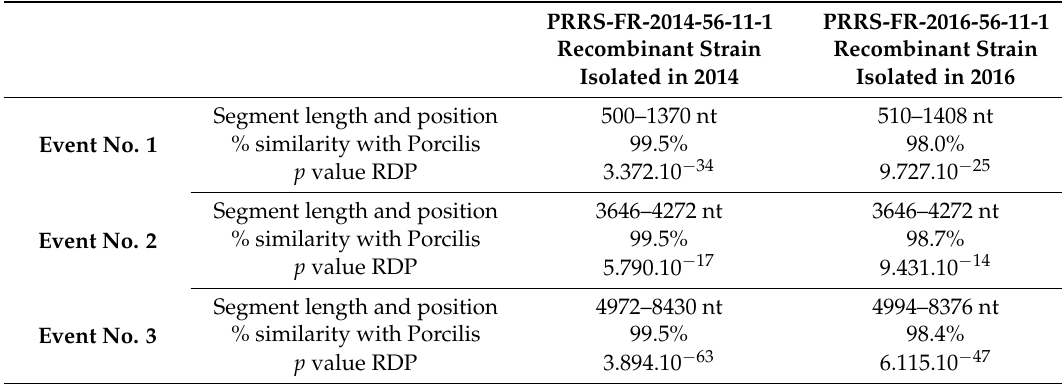
Figure 4. Full-genome similarities between the recombinant strain from 2016 and the vaccine strains or the recombinant strain from 2014. ( a ) Comparison of full-genome similarities with the recombinant strain isolated in 2016 and the Porcilis ® PRRS and Unistrain ® PRRS parental vaccine strains. ( b ) Comparison of full-genome similarities between the recombinant strains isolated in 2014 and 2016. Plots of similarity were generated with the Simplot program using the recombinant strain isolated in 2016 as the genome reference for both graphs. Table 2. Comparison of the three recombination events identified with RDP4 software for PRRSV recombinant strains isolated on the farm in 2014 and 2016.